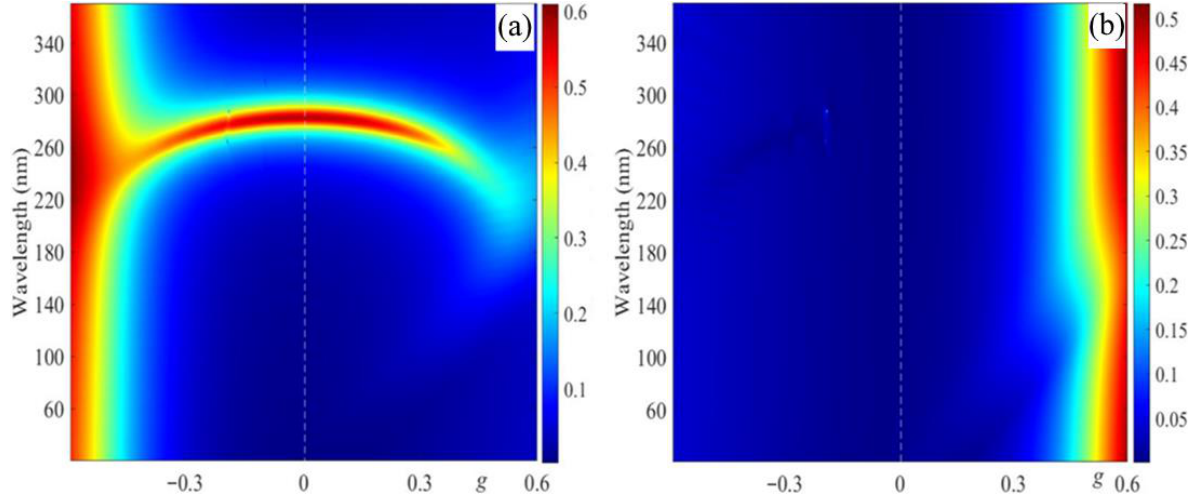
Figure 4. The evolution of the reflection spectra with a change in g for incident light with polarization coinciding with its ( a ) diffracting EP and ( b ) non-diffracting EP. Materials 2021 , 14 , 2172